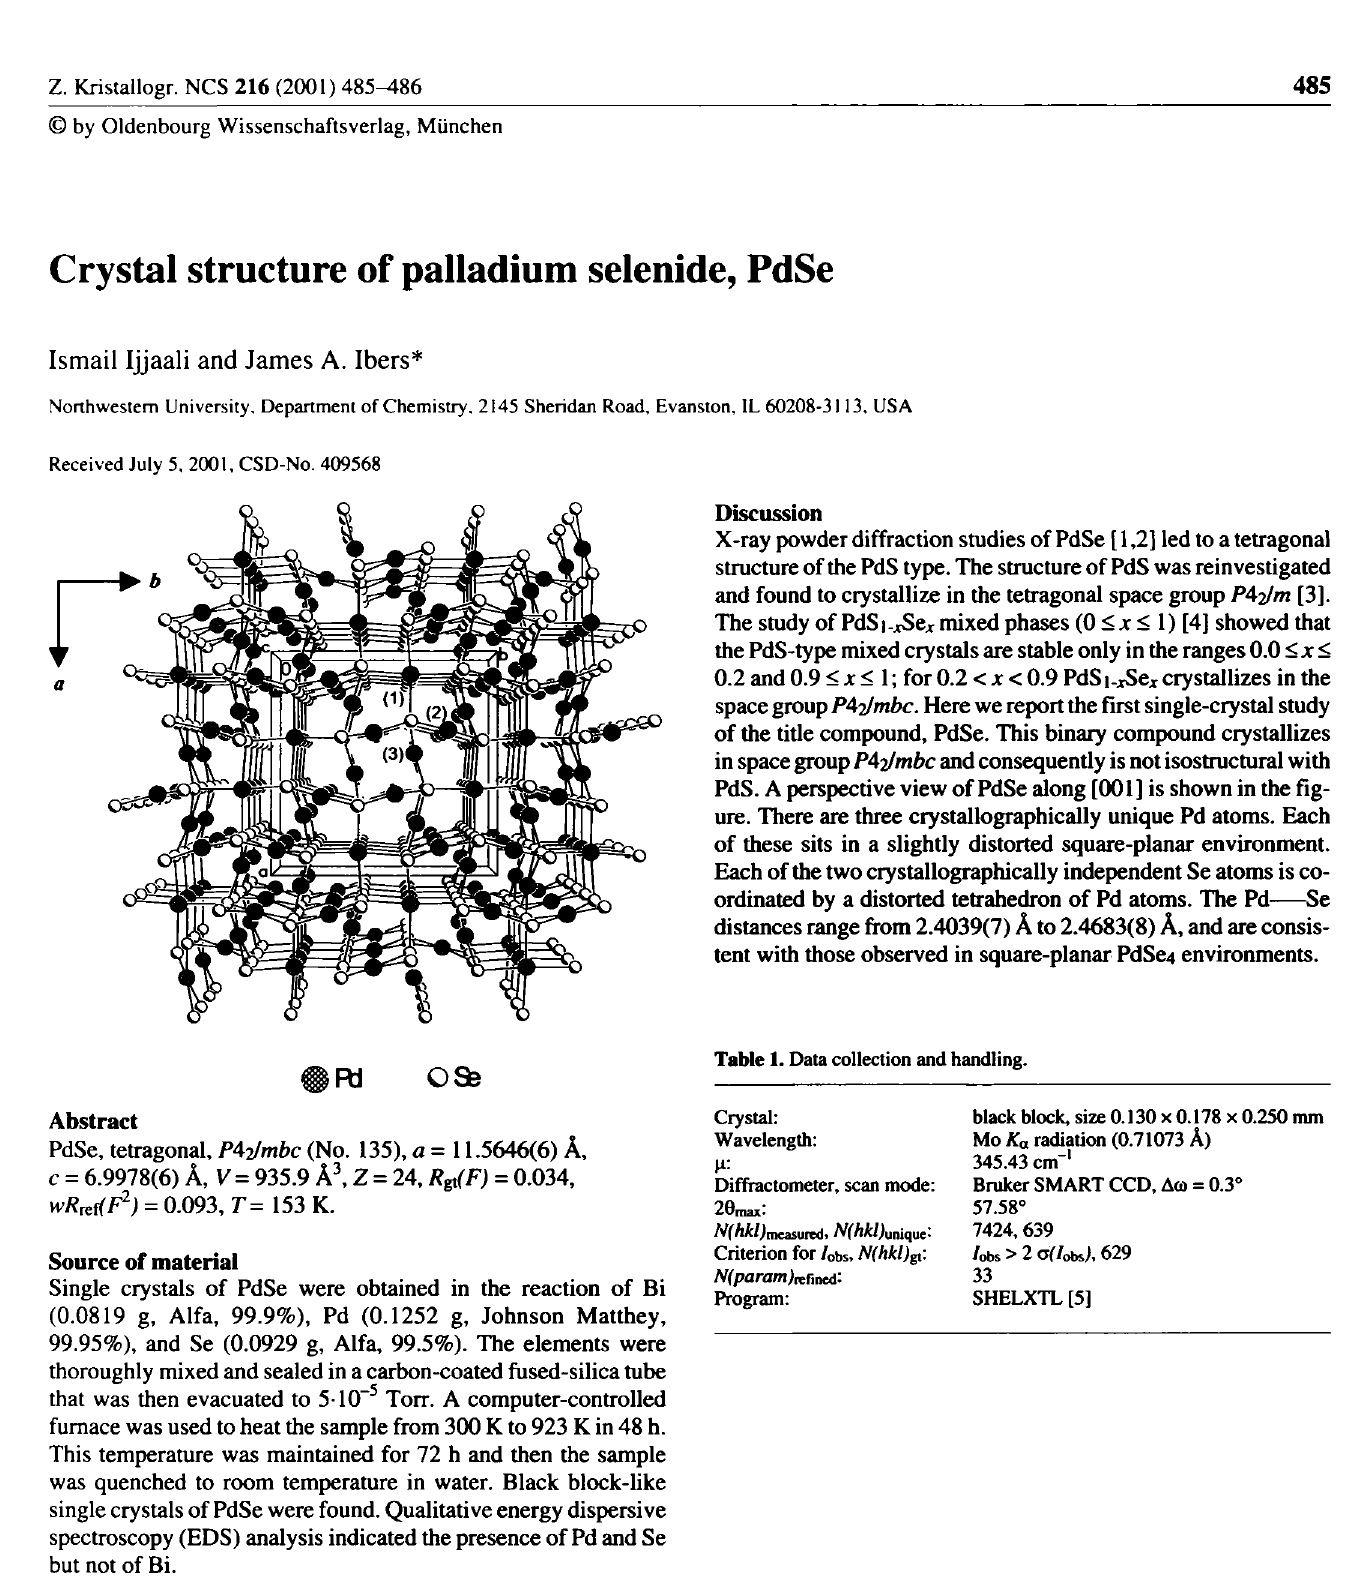
Table 2. Atomic coordinates and displacement parameters (in A 2